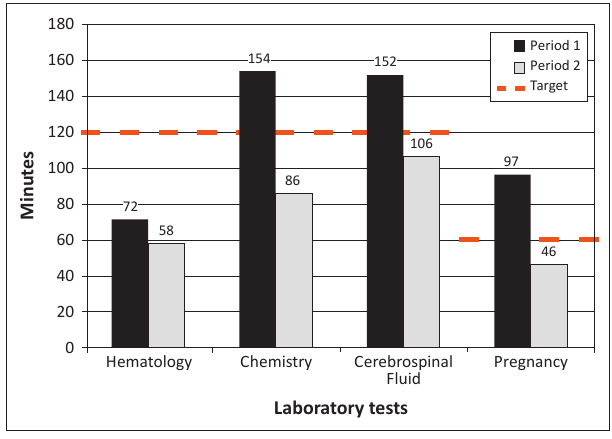
FIGURE 1: Average turnaround time (minutes) for laboratory tests in April to September 2011 (period 1) and October 2011 to March 2012 (period